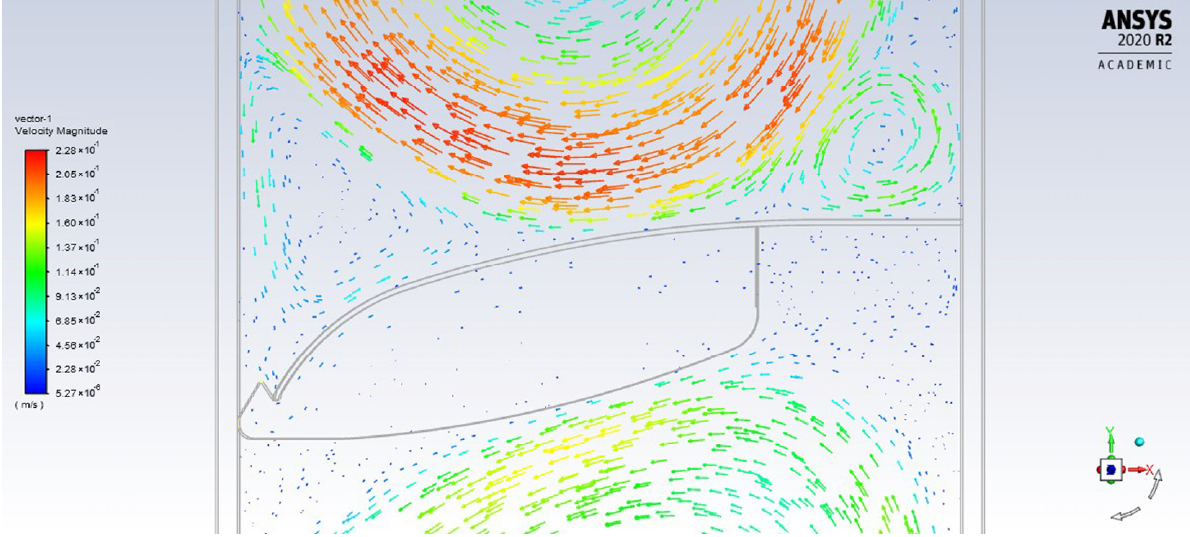
Figure 11. Velocity vectors plot in free convection operation mode.